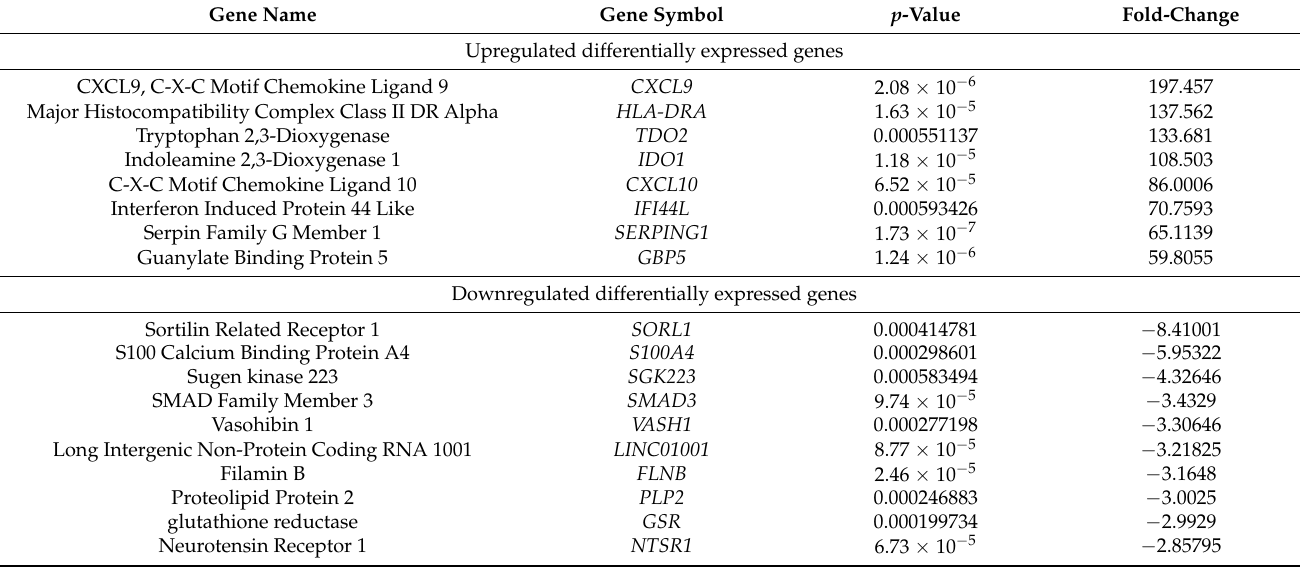
Table 1. Genes most significantly up- and downregulated by IFN- γ treatment vs. control.